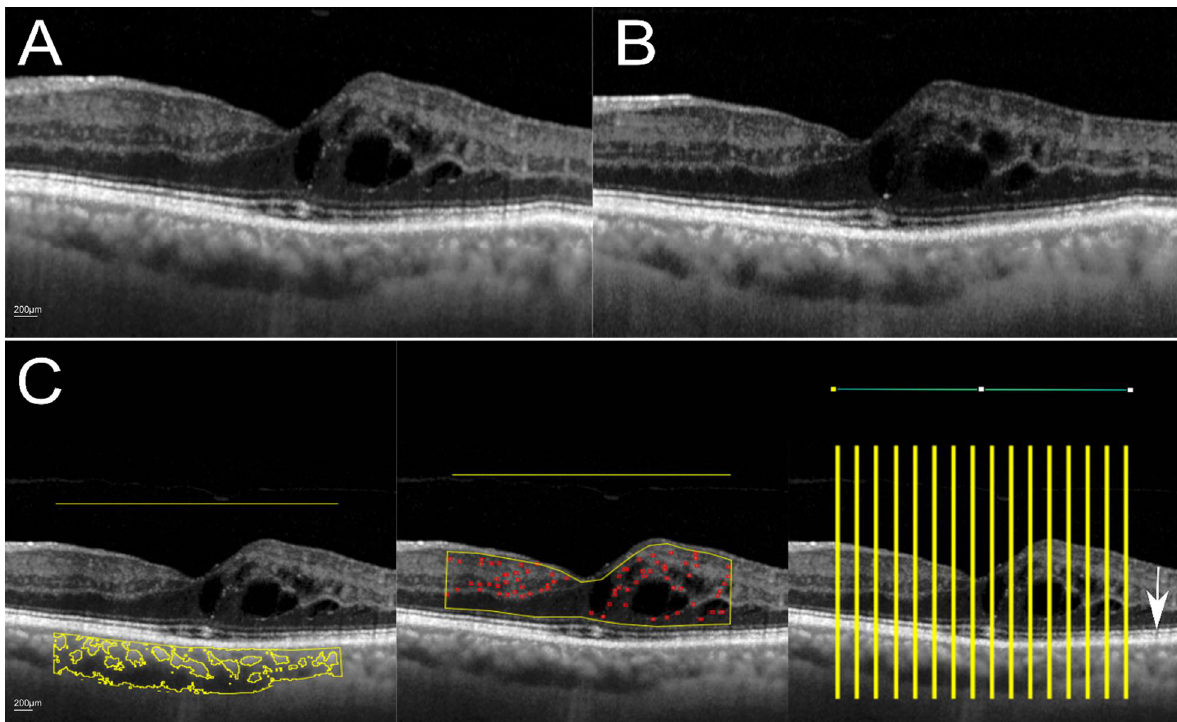
Figure 1. Spectral domain-OCT without ( A ) and with ( B ) enhanced depth imaging mode and ( C ) region of interest according to OCT biomarkers of interest. ROI for CVI and HF was derived from the EDI image. C Left: Choroidal vascularity index was calculated according to the protocol of Agrawal et al. [15] . Middle: For the quantification of hyperreflective foci (red circles), we applied the protocol described by Midena et al. [23] Right: EZR was quantified automatically in 200 µm distances between each ROI (in total 16 measurements). Horizontal line in the upper part of the image represents the central 3 mm area. White scale bar at the bottom left corner in A and C represent 200 µm. White arrow indicates the ellipsoid zone.